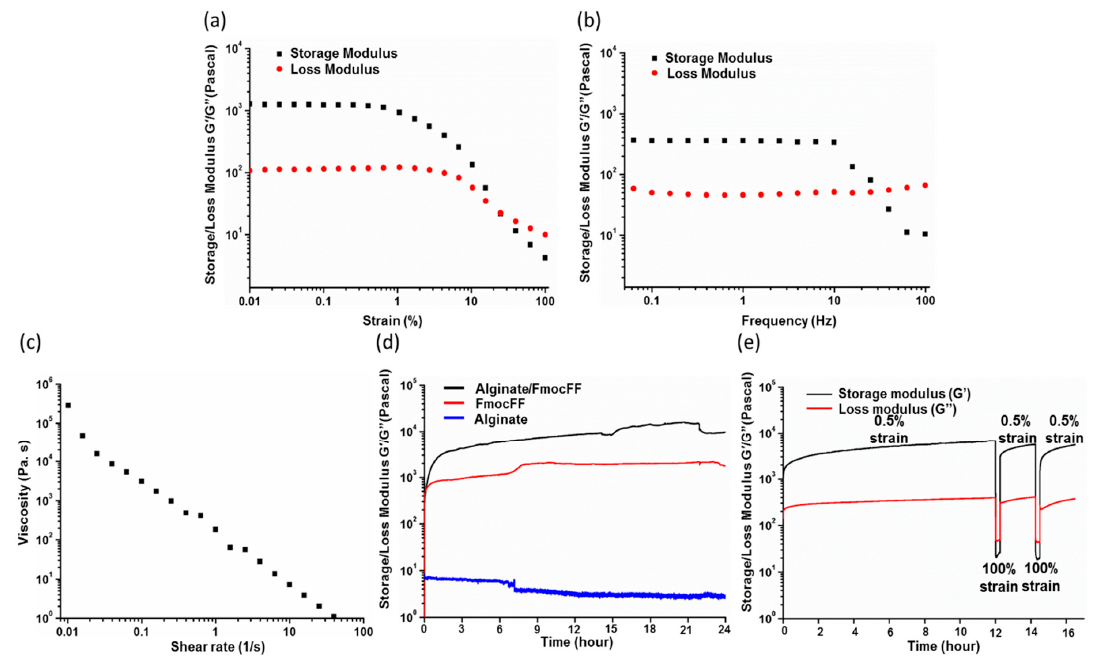
Figure 2. Rheological characterization of the hydrogels. ( a ) Strain sweep of the Alginate/FmocFF composite hydrogel. ( b ) Frequency sweep of the Alginate/FmocFF composite hydrogel. ( c ) Viscosity versus shear rate of the Alginate/FmocFF composite hydrogel. ( d ) In situ time sweep oscillation measurements of hydrogels formation by pure alginate, FmocFF, and Alginate/FmocFF composite gel for 24 h. ( e ) G’ and G” of Alginate/FmocFF composite hydrogel on time sweep (0–120 min) and subsequent step strain (0.5% and 100%) measurements.